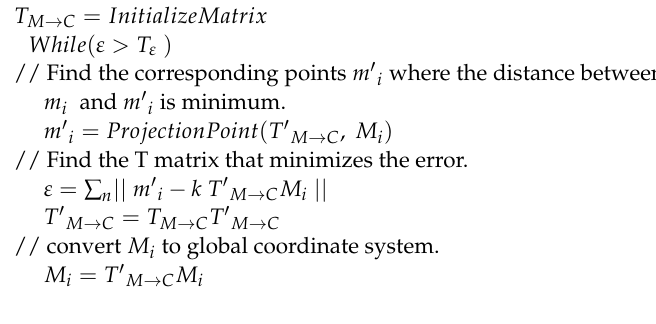
Figure 16. Example of the 3D points of a 3D model projected onto a 2D image of the camera.